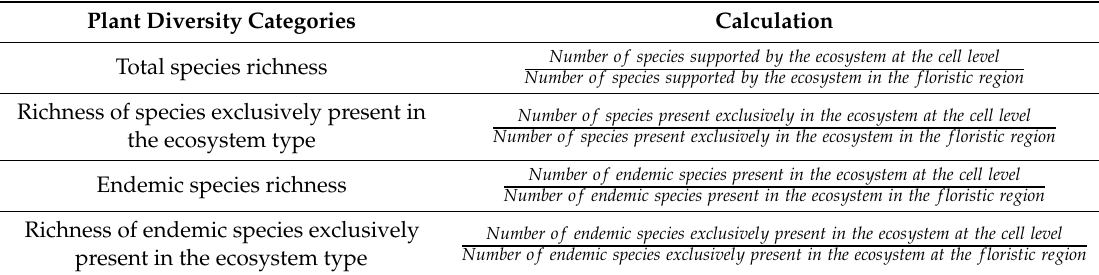
Table 1. Description of the proposed method for species-richness calculations for the four plant diversity categories.